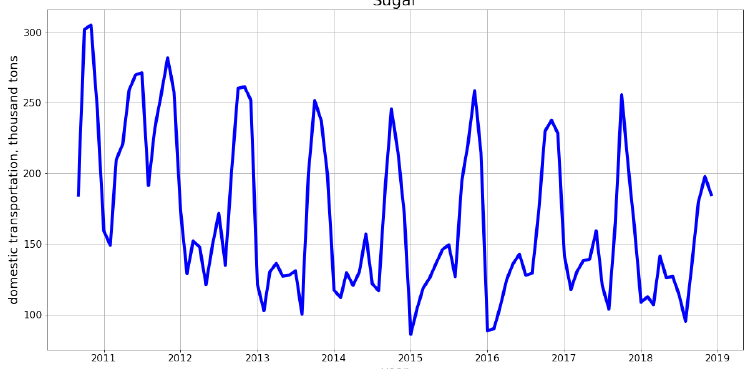
Figure 1. Domestic rail transport of sugar in the Russian Federation.